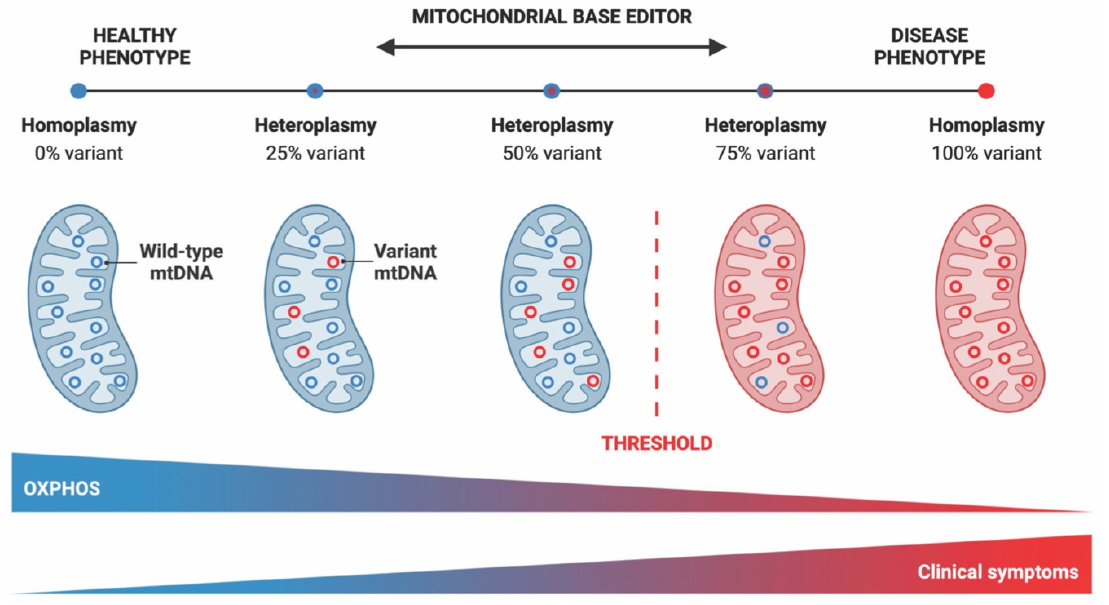
Figure 1. Heteroplasmy shifting with mitochondrial DNA base editors. The threshold of mtDNA heteroplasmy determines the onset of phenotypic manifestations. Generally, a threshold percentage of variant mtDNA must be surpassed for decreased OXPHOS and disease phenotypes. In general, the specific functional threshold depends on the mutation, cell type, and tissue type for a detectable phenotype. Utilizing programmable mitochondrial DNA base editors, heteroplasmy levels can be manipulated to create disease models or correct deleterious mutations. (This figure was created with BioRender.com, accessed on 15 January 2023).